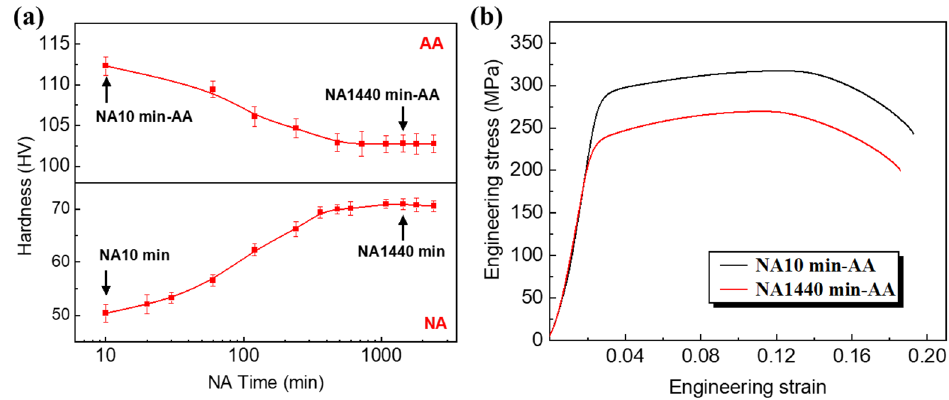
Figure 1. ( a ) NA and AA hardness curves of the Al-Mg-Si alloy. ( b ) Engineering stress–strain curves of NA10 min-AA and NA1440 min-AA.